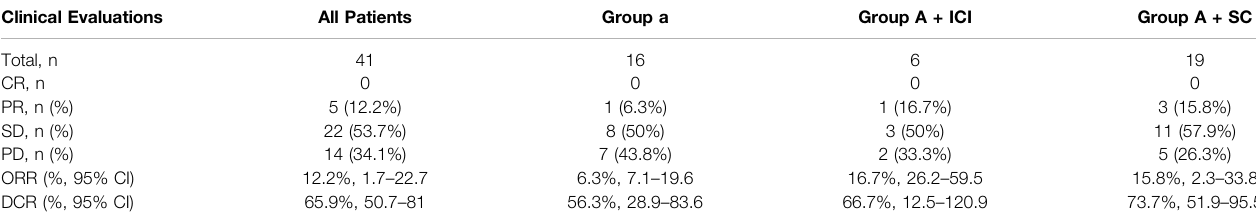
TABLE 2 | Treatment